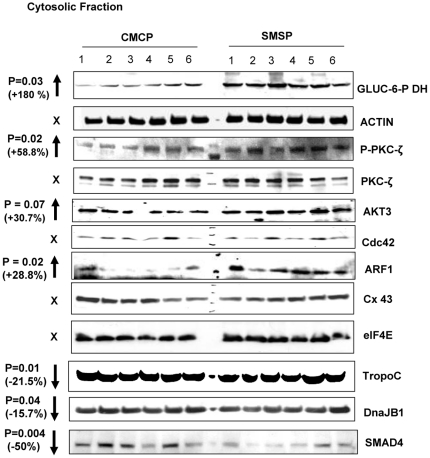
Cellular fractionation of possible target proteins: Cytosolic fraction.Insulin signaling marker is up-regulated along with the metabolic marker glucose-6-phospahe dehydrogenase and ARF1 GTPase, whereas SKM marker Tropomyocin C is down-regulated along with two essential signaling candidates SMAD4 and DnaJ-B1.